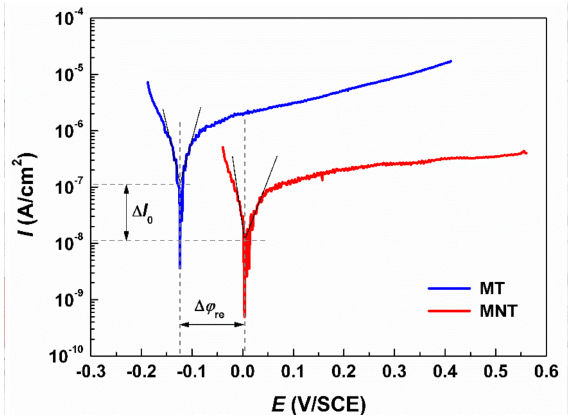
Figure 6. Polarization plots of as-sprayed (MT) coating and micro/nano tantalum (MNT) coating. The intersections of the anodic and cathodic Tafel slopes of the polarization curves indicate the corrosion potentials ( Ψ re ) and corrosion currents ( I o ). The test solution is SBF at room temperature.